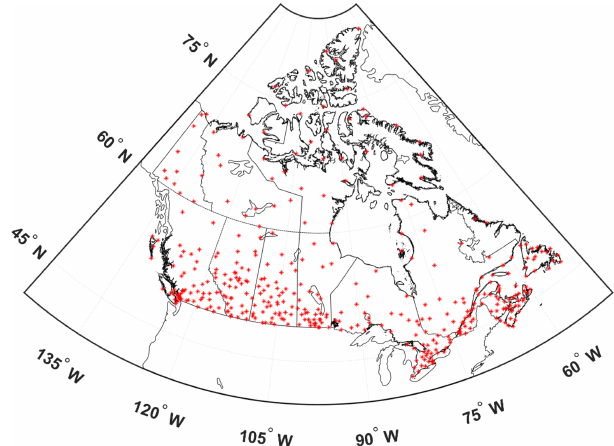
Figure 3. Location of the 397 ECCC automated climate stations selected for the application of the SPICE UTF.